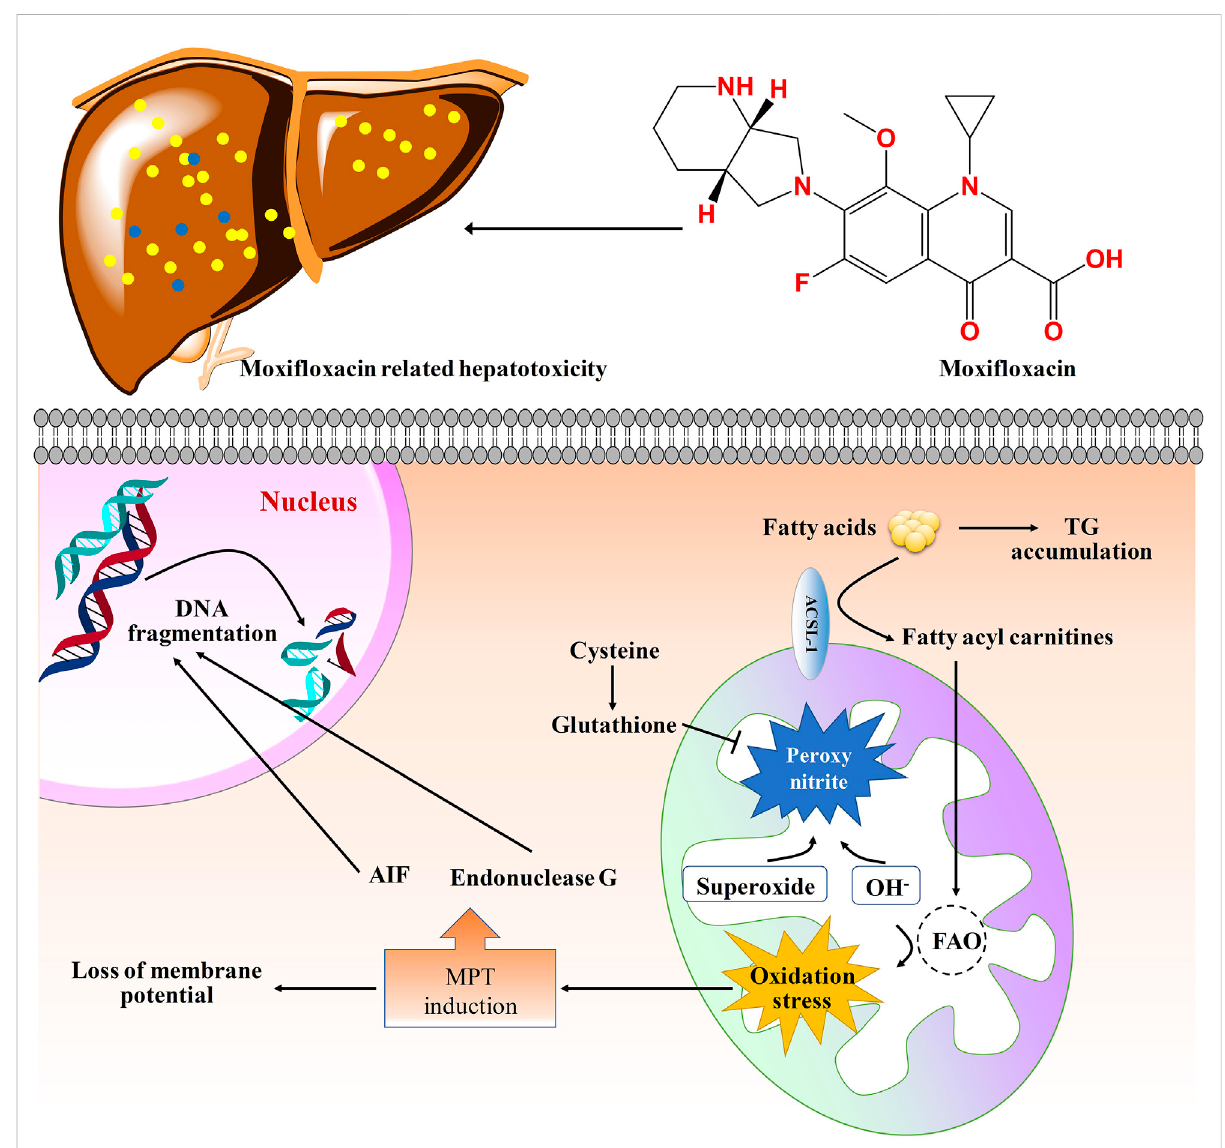
Molecular network diagram of thetoxic and side effects of moxi fl oxacin on theliver tissue. Moxi fl oxacin administration could up-regulated the levels of fatty acyl carnitines, thus increased the generation of ROS. The generation of ROS will cause damage to biological macromolecules. The MPT (mitochondrial permeability transition) triggers matrix swelling with rupture of the outer member and release of intermembrane proteins including apoptosis-inducing factor (AIF) and endonuclease G, which translocate to the nucleus and cause nuclear DNA fragmentation (Woolbright and Jaeschke, 2017). GSH can scavenge ROS and peroxynitrite in mitochondria. TG, triglycerides; FAO, fatty acid